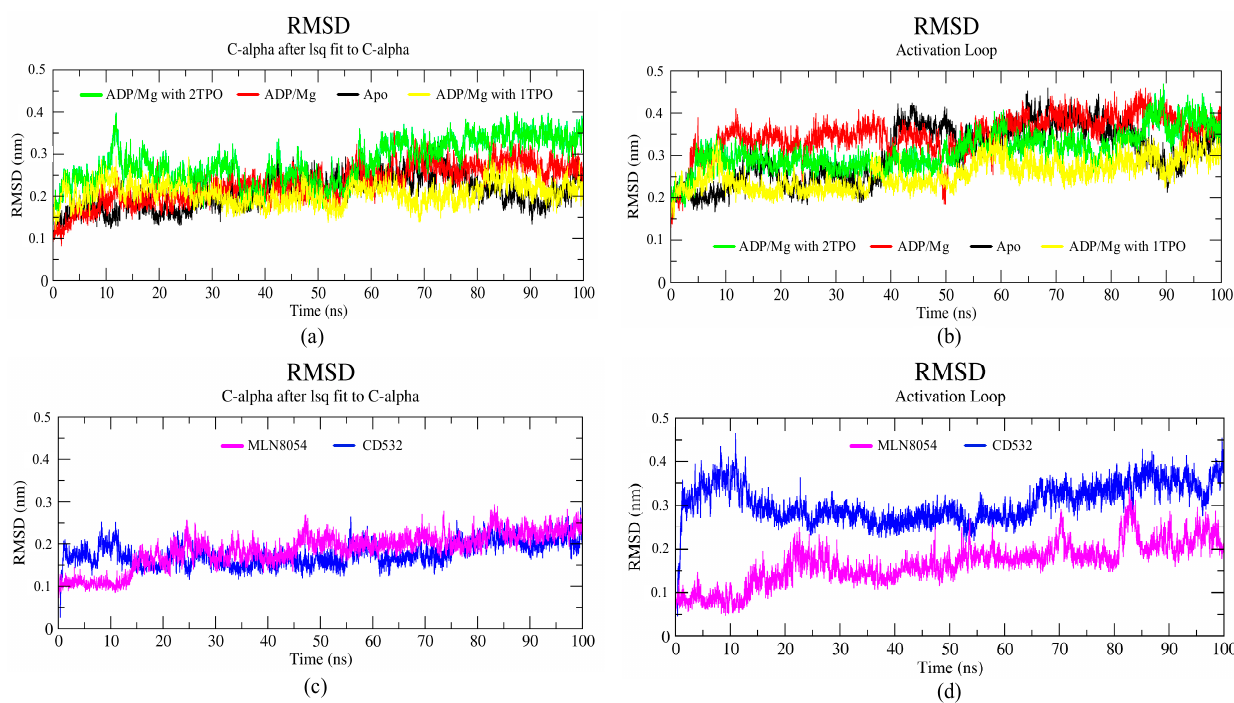
Figure 3. Backbone root mean square deviation (RMSD) of the Aurora-A protein for 100 ns MD. ( a ) RMSD plot of open/active states. ( b ) RMSD value of the A-loop in the active states: apo (4J8N, black), ADP/Mg (1MQ4, red), ADP/Mg with 2TPO (1OL7, green), ADP/Mg with single TPO (1OL7, yellow). ( c ) RMSD plot of inactive states. ( d ) RMSD value of A-loop in the inactive states: CD532 (4J8M, blue), MLN8054 (2WTV, pink).